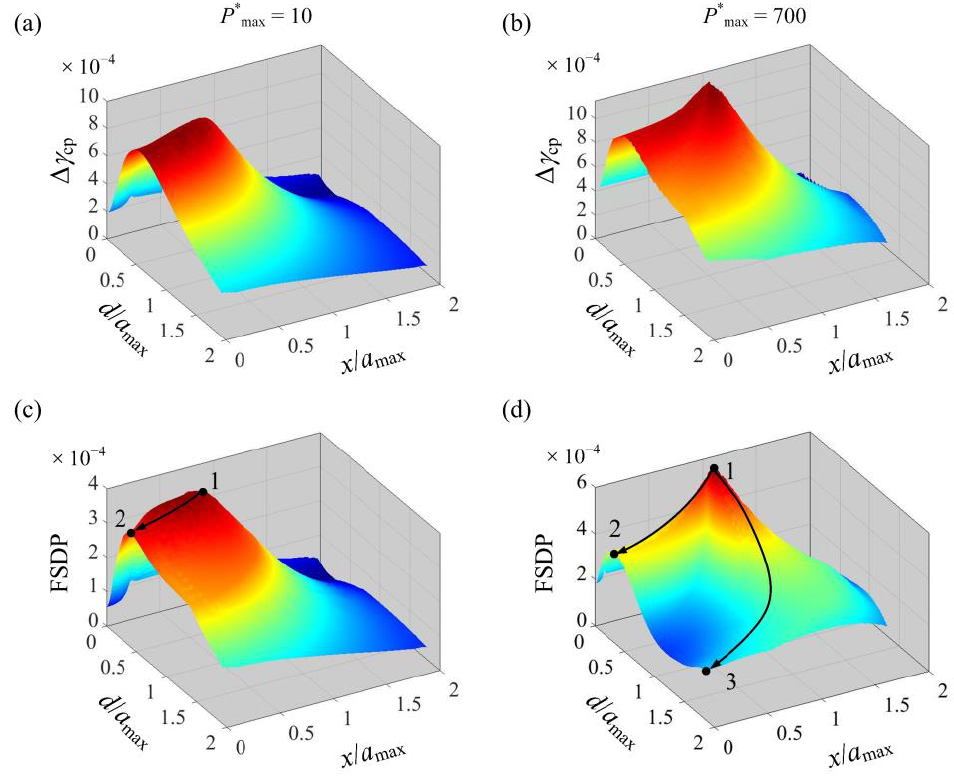
Figure 7. Examples for the typical patterns of Δ γ cp contour and FSDP contour for P * max < 30 and P * max ≥ 30, where ( a , c ) P * max = 10 and ( b , d ) P * max = 700.